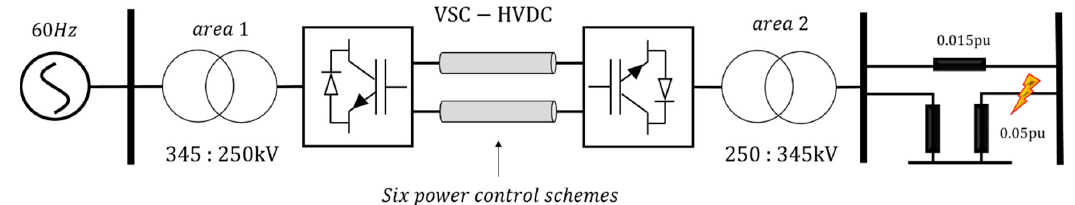
Figure 9. System configuration for simulation studies. Table 2. System parameters.